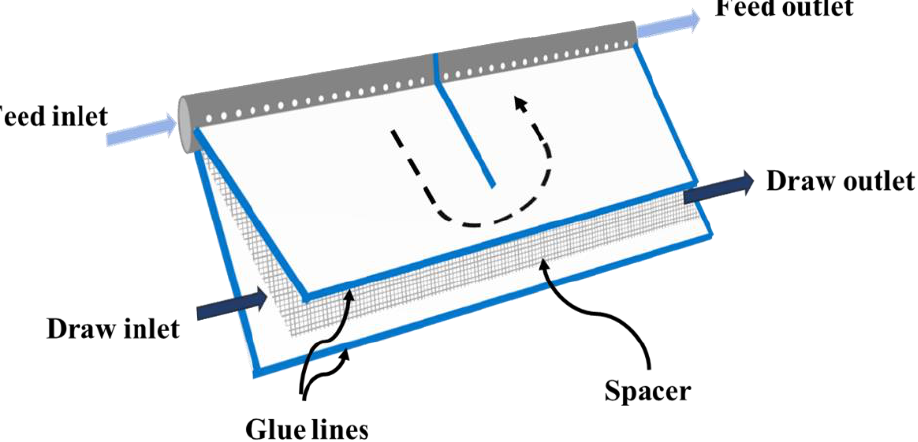
Figure 7. An illustration of the flow path for the commercial SWM.